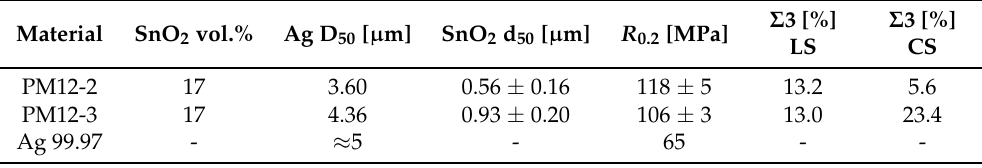
Table 1. A list of some essential properties of the investigated MMC and the pure Ag produced by the PM process (LS: longitudinal section, CS: cross-section) [13].